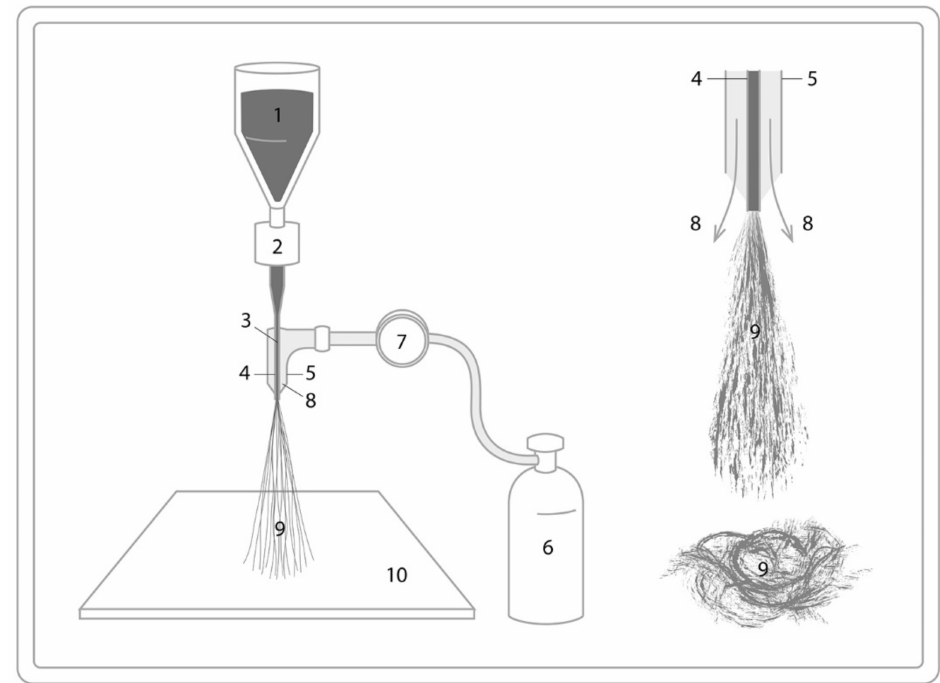
Figure 7. Schematic of the solution blowing process with the polymer (1), coaxial pump (2), syringe (3), polymer solution (4), air supply (5), high pressure air pump (5), valve (7), air (8), stretched polymer jet (9), and the fiber collector (10).